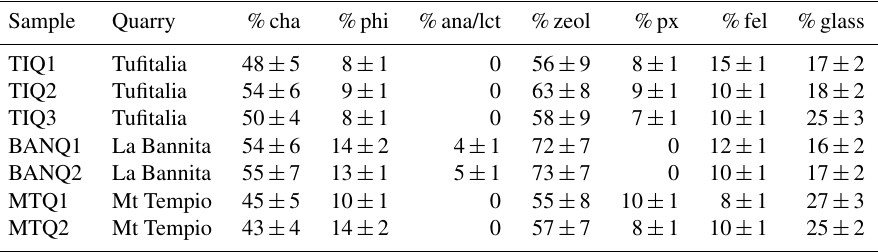
Table 3. Mineralogical composition of the studied samples. Zeol: zeolites (chabazite and phillipsite); px: pyroxene; fel: sanidine and plagio- clase; lct: leucite; ana: